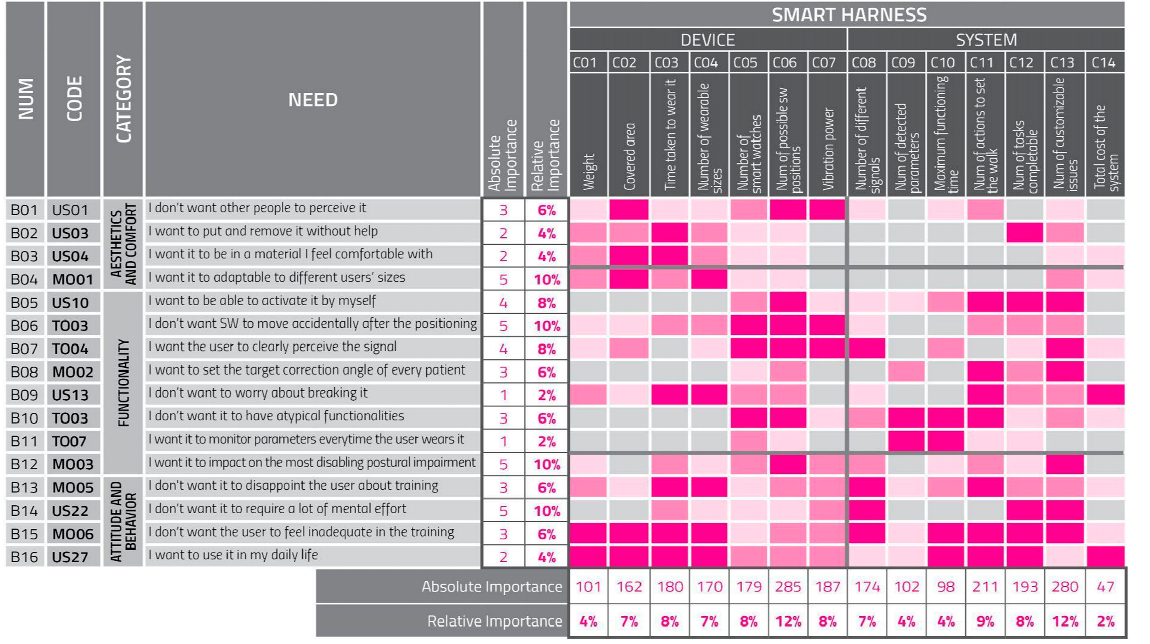
Figure 1. Quality function deployment matrix for the smart harness. Relationships between needs and characteristics are defined to evaluate their impact on the whole project. The use of colors helped team members use and interpret the QFD matrix (even if they were not experts). The QFD algorithm provided percentages representing each [29].